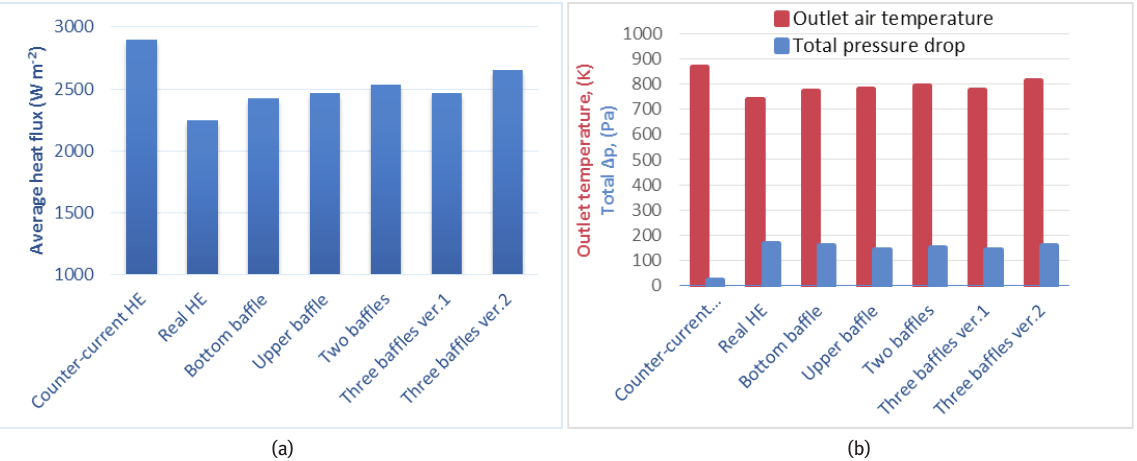
Figure 5: Results of calculations for the considered heat exchanger (HE) geometries: a) Average heat stream, b) Total pressure drop and outlet air